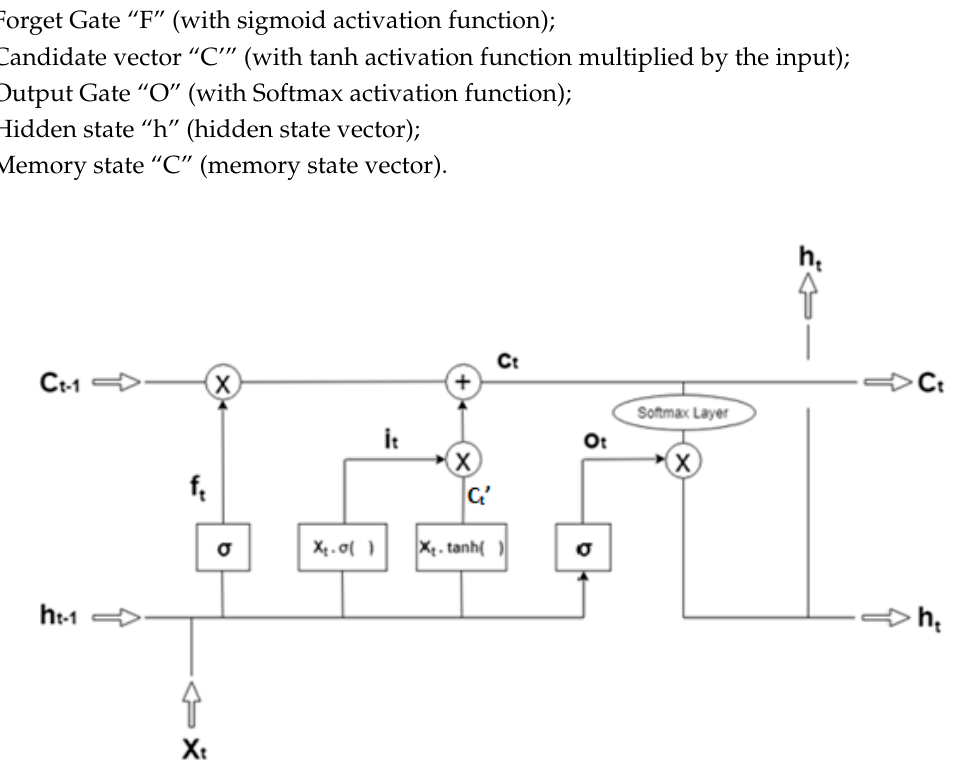
Figure 2. Schematic representation of Intensified LSTM.